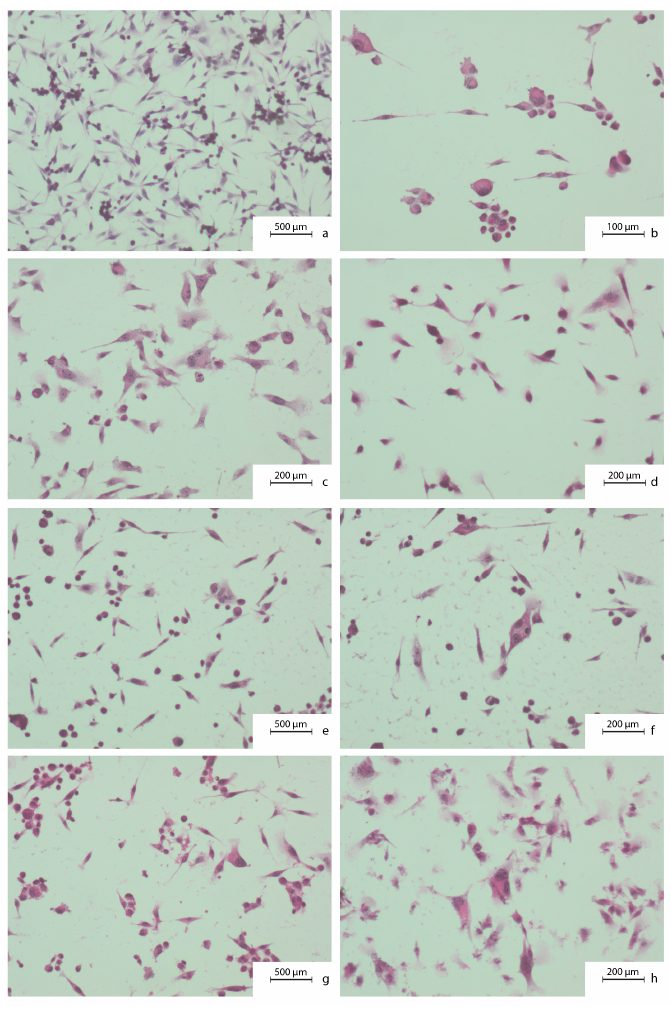
Figure 1. Cytomorphological view of MDA-MB-231 breast cancer cells without any treatment ( a – d ) as well as after 24 h of caffeic acid (CA) ( e , f ) and 24 h of caffeic acid phenethyl ester (CAPE) treatment ( g , h ), both with a 50 µM dose. To prepare the samples a hematoxylin and eosin staining was used. Exposition: optical magnification ×100 ( a , e , g ), ×400 ( c , d , f , h ), ×600 ( b ). Main features: ( a ) phenotypically as spindle-shaped cells (caudate, tadpole), hyperchromasia; ( b ) irregular nuclear shapes, small clusters of cells around the large ones; ( c ) large nuclei with irregular shape and several nucleoli in the nucleus; ( d ) pleomorphism of size, shape, and coloration of nuclei and whole cells; ( e ) karyopyknosis; ( f ) lower cell-cell contact; ( g ) karyopyknosis, cytoplasm density; ( h ) cytoplasm density and a shape change, cytoplasm